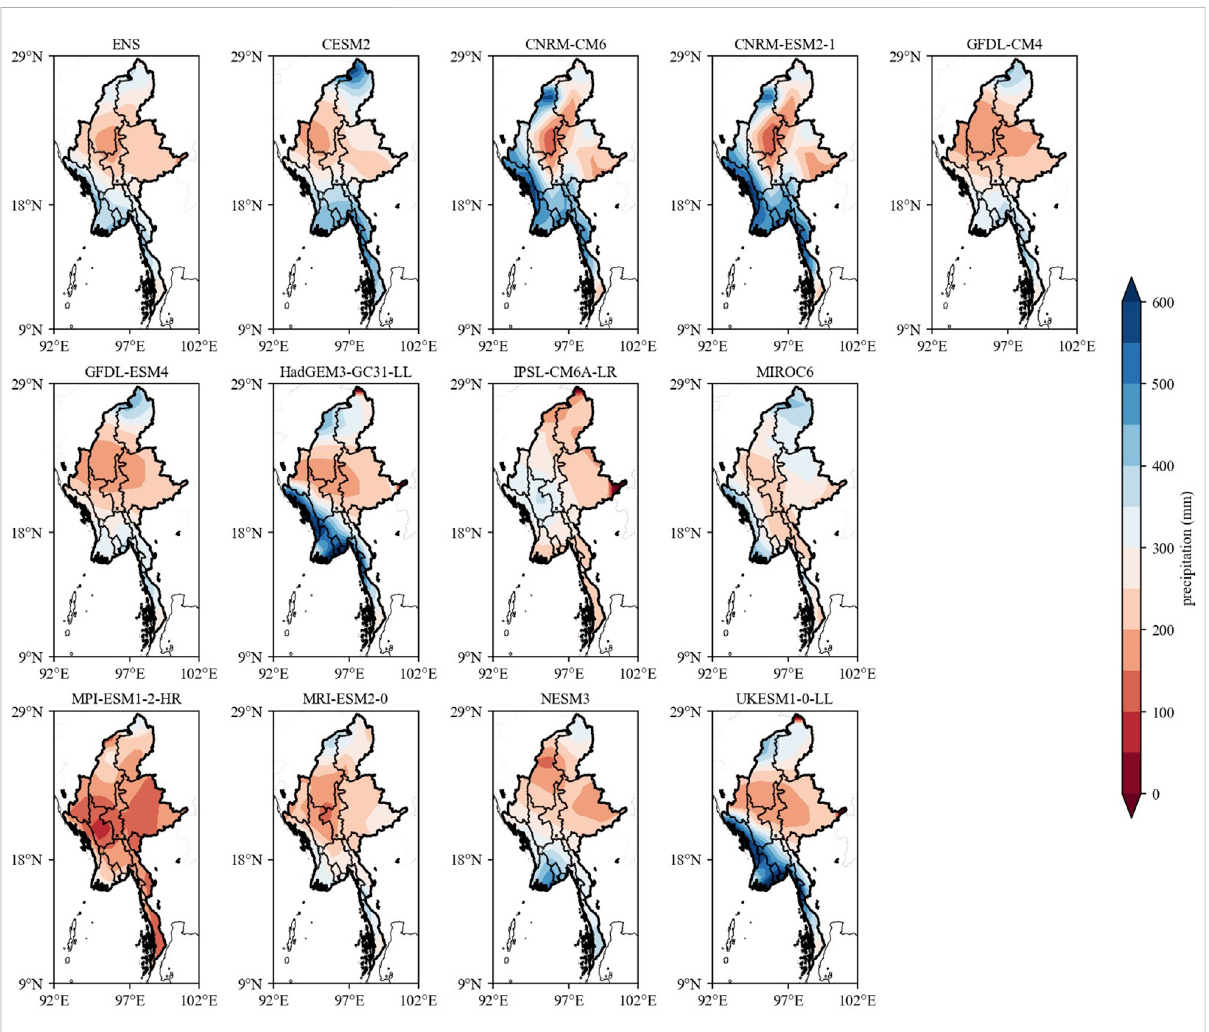
FIGURE 5 Spatial distribution of seasonal mean precipitation for the selected 12 CMIP6 models as well as their ensemble mean during 1970 – 2014